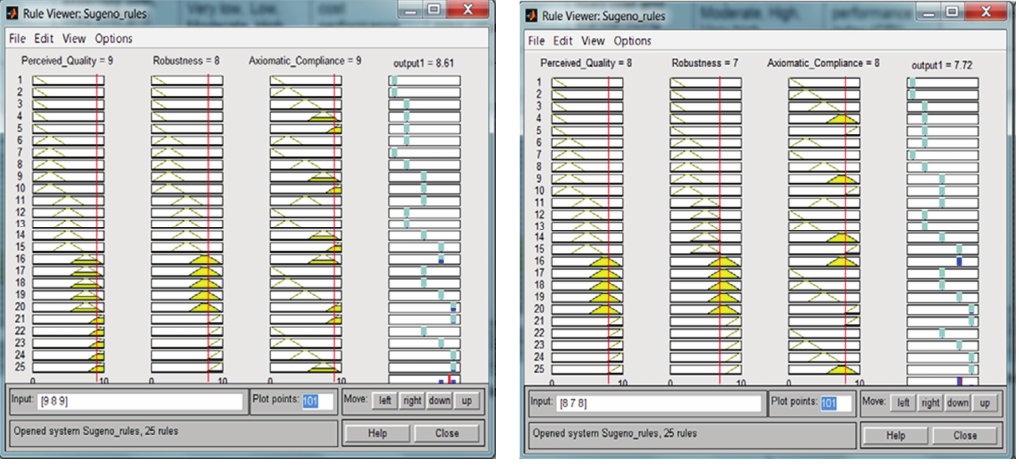
Figure 5: Rule viewer of